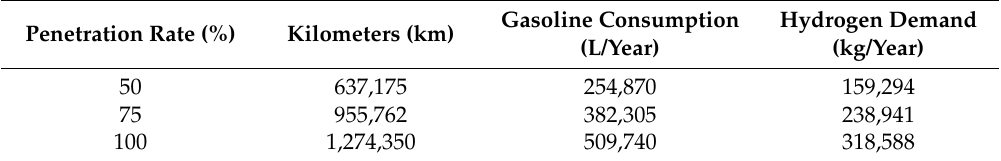
Table 2. Penetration scenarios and hydrogen requirement.